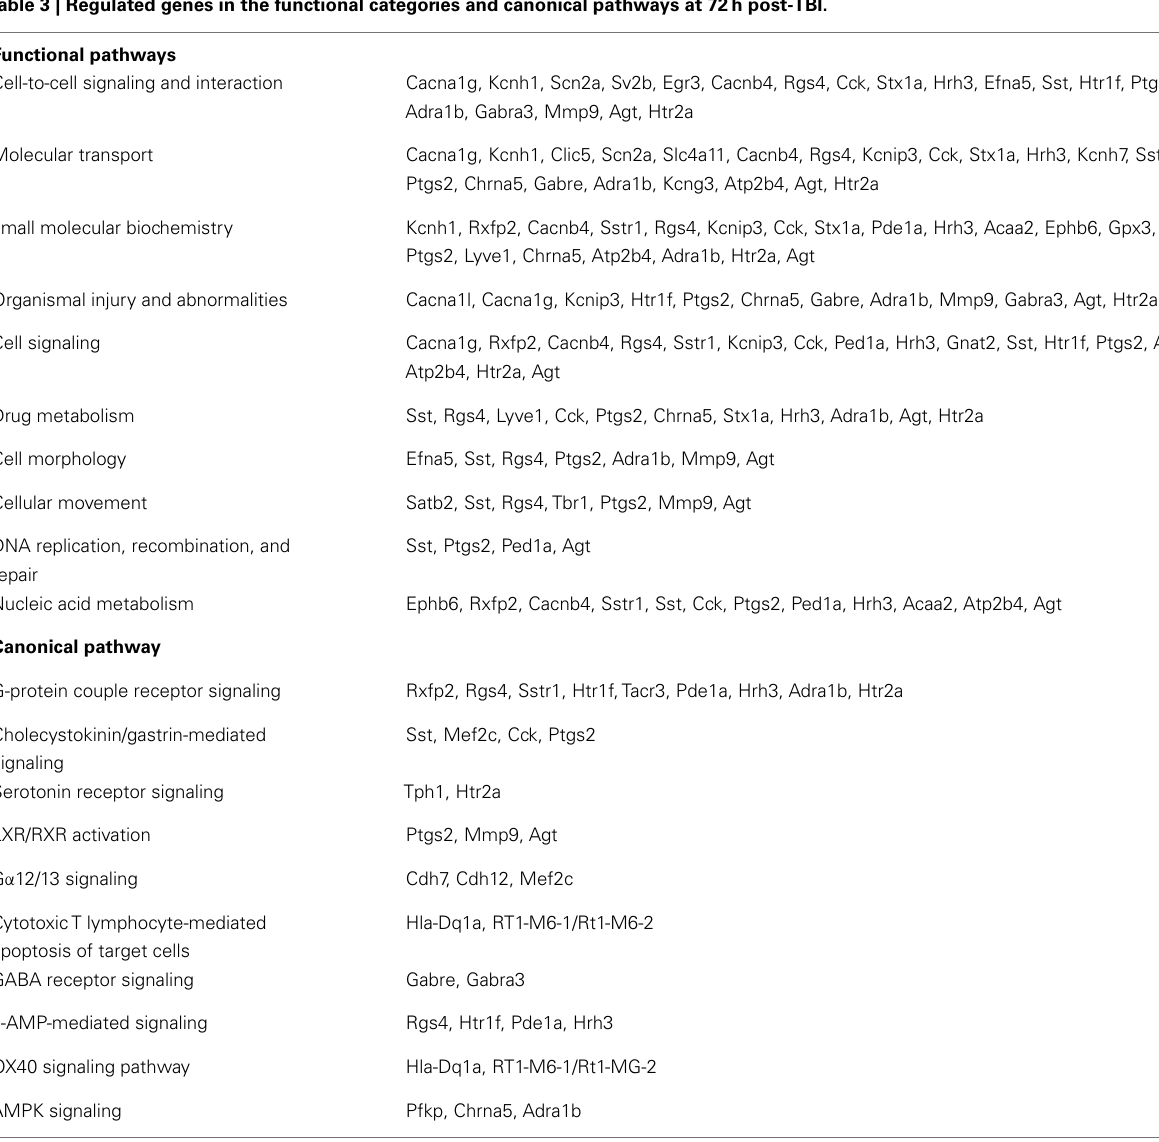
Table 3 | Regulated genes in the functional categories and canonical pathways at 72h post-TBI. Functional